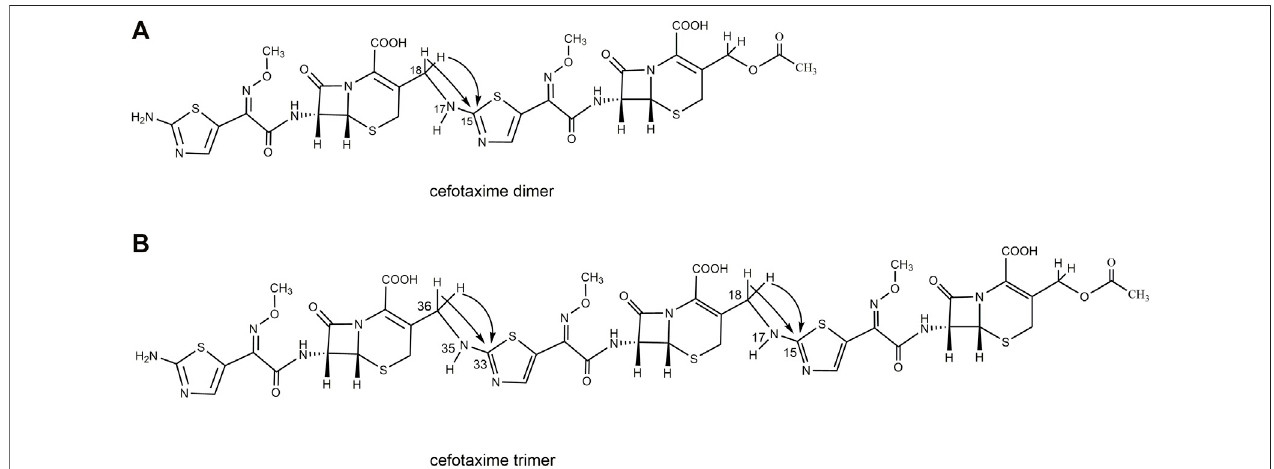
FIGURE 5 | The scheme of partial HMBC correlation ship of cefotaxime dimer and trimer.